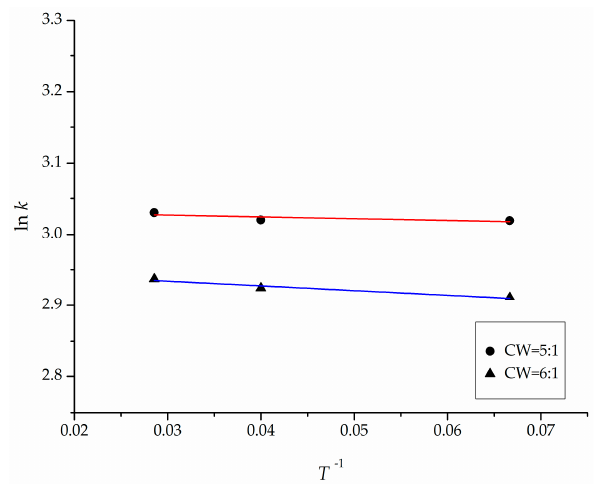
Figure 4. The lnk-1 / T curve. Figure 4. The lnk-1/T curve.